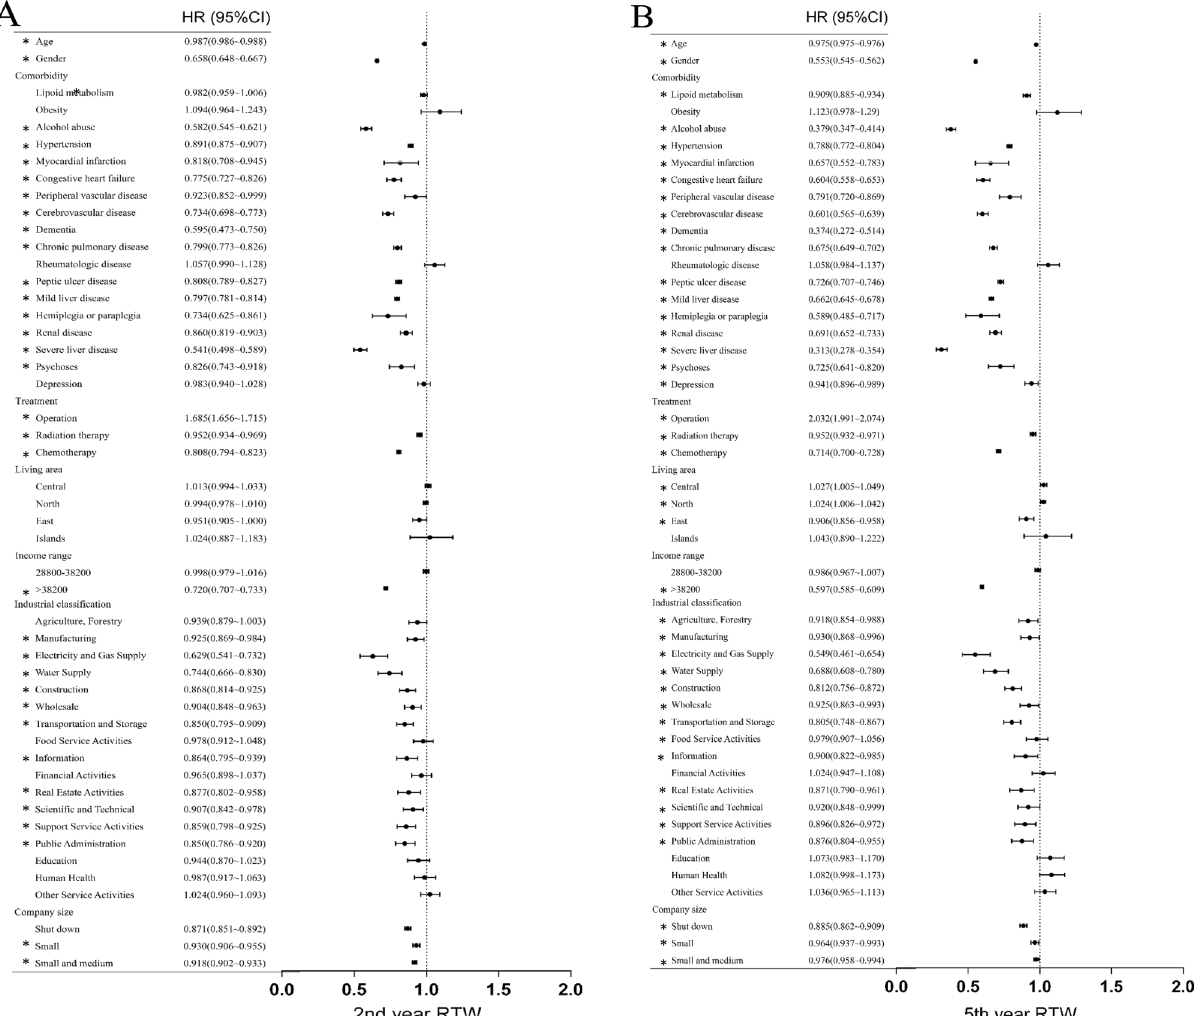
Figure 1. Univariate association between independent variables and RTW in the 2nd and 5th